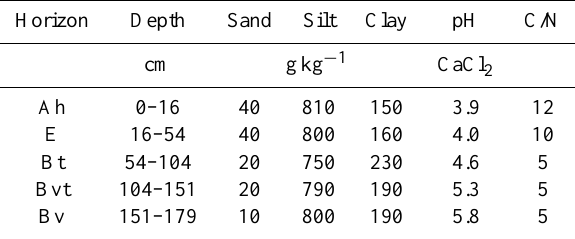
Table 1. Soil properties of the investigated Haplic Luvisol in the Forchtenberg experimental site (data provided by L.